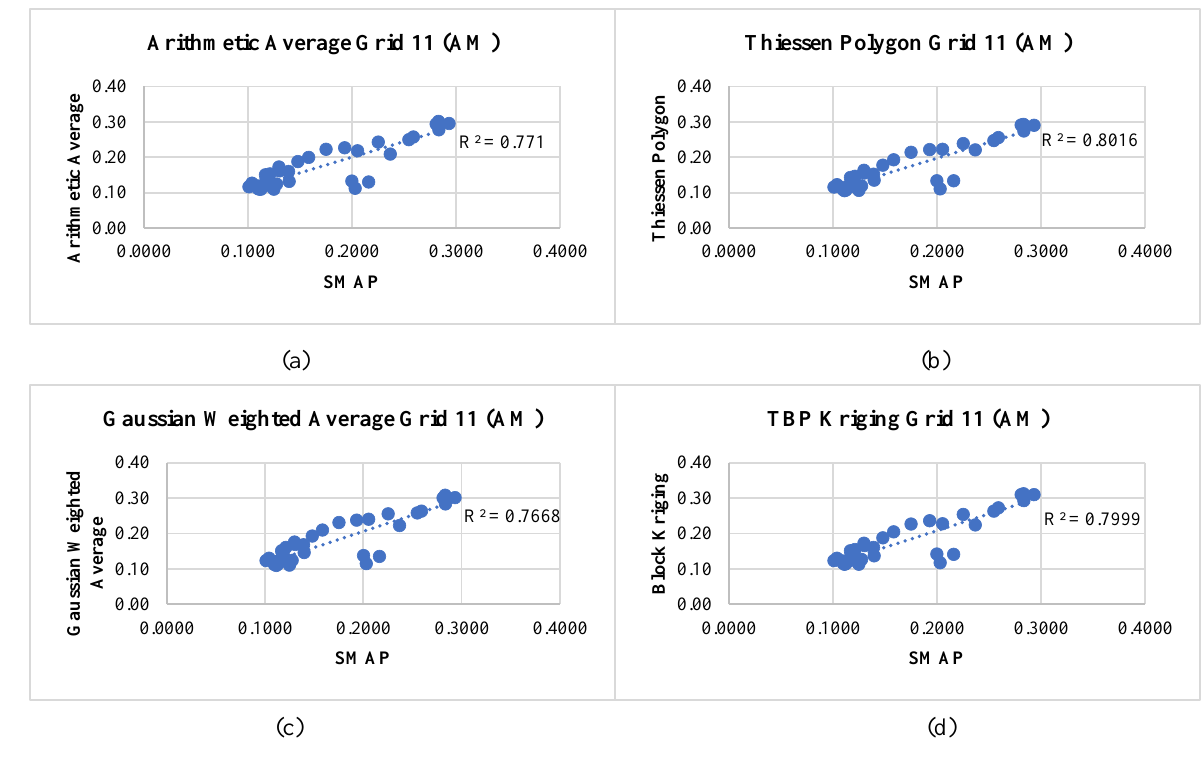
Figure 12. Grid 11 — spatial autocorrelation not detected: correlation plot between the morning SMAP data and the four upscaling algorithms. ( a ) arithmetic average; ( b ) Thiessen polygon method; ( c ) Gaussian-weighted average; ( d ) TBP kriging. Table 4. Model Performance Comparison for the AM/PM Data Grid 11.